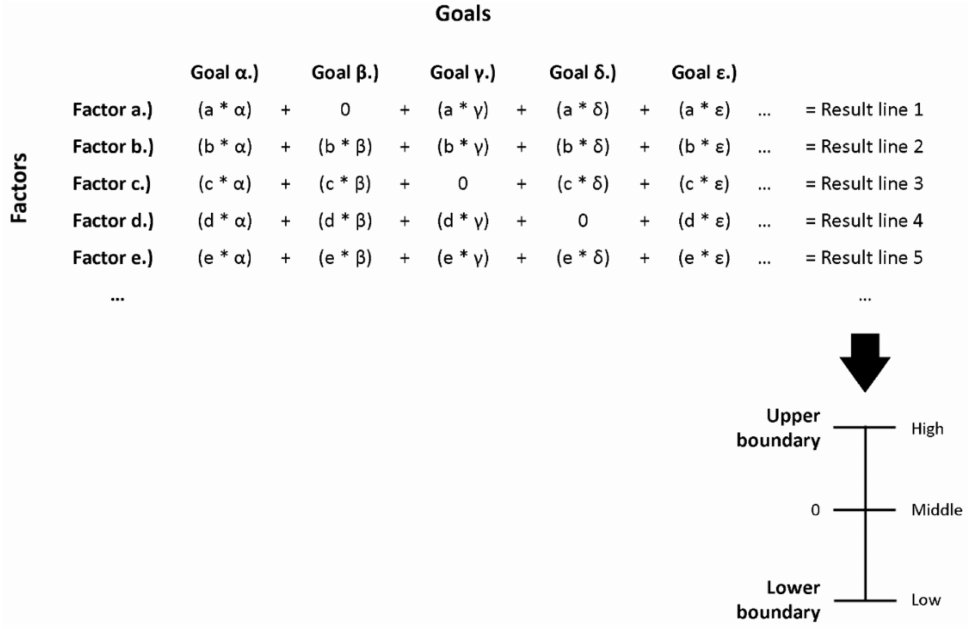
Figure 2. Multiple-criteria decision analysis scheme